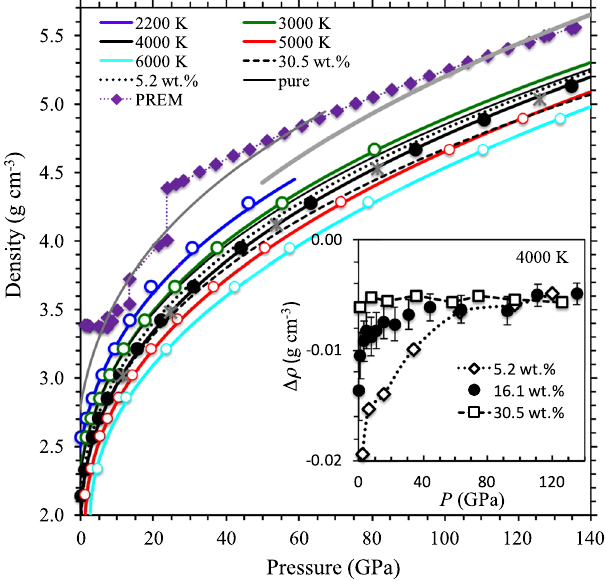
Figure 4. Density-pressure profiles of MgSiO 3 liquid. The calculated density results for the melt containing 16.1 wt.% CO 2 at various temperatures (thick lines with circles), compared with the results for liquids containing 5.2 and 30.5 wt.% CO 2 (black dotted and dashed lines) and the pure liquid (black thin line) at 4000 K. In all cases, the lines represent the equation of state fits. Also shown is the liquid density at 4000 K (asterisks) for the same amount of elemental carbon as in case of 16.1 wt.% CO 2 . The estimated density profiles of (Mg 1 − x ,Fe x )SiO 3 melt with 5 wt.% CO 2 at 2200 K (with x = 0.22) and 4000 K (with x = 0.27) shown by thin and thick gray curves are compared with the seismic density profile (PREM) 38 . The inset shows the changes in the silicate melt density